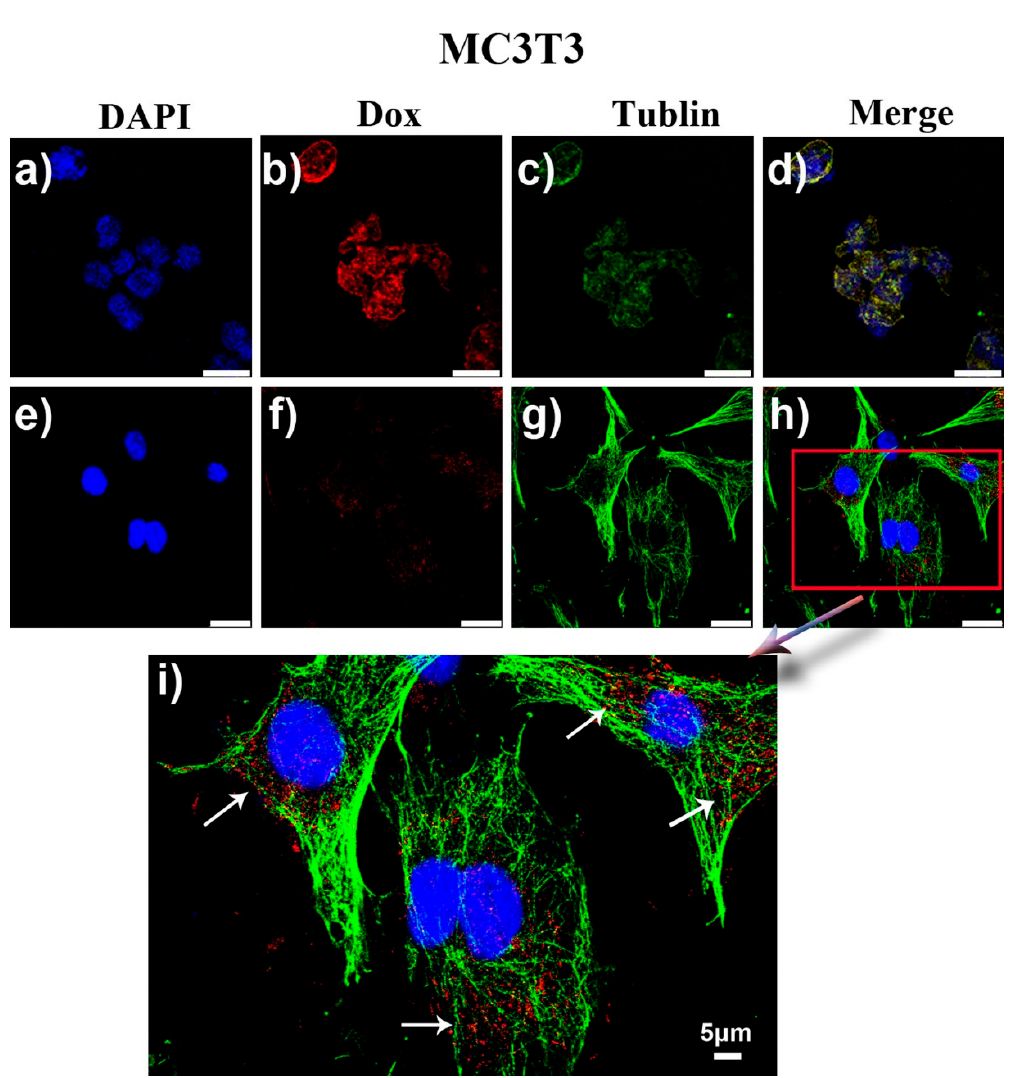
Figure 7. MC3T3 cells cultured in different conditions for 24 h: ( a – d ) with free Dox (1 μ g/mL), ( e – h ) with DCAT NSs (concentration of Dox = 1 μ g/mL); ( i ) magnified image of ( h ). The incubated pH is 7.4.